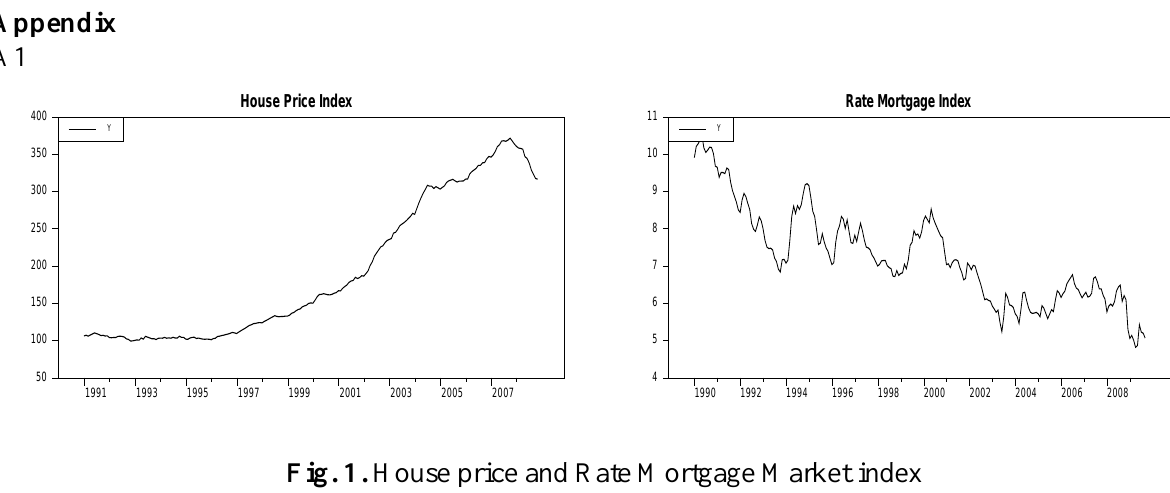
Fig. 1. House price and Rate Mortgage Market